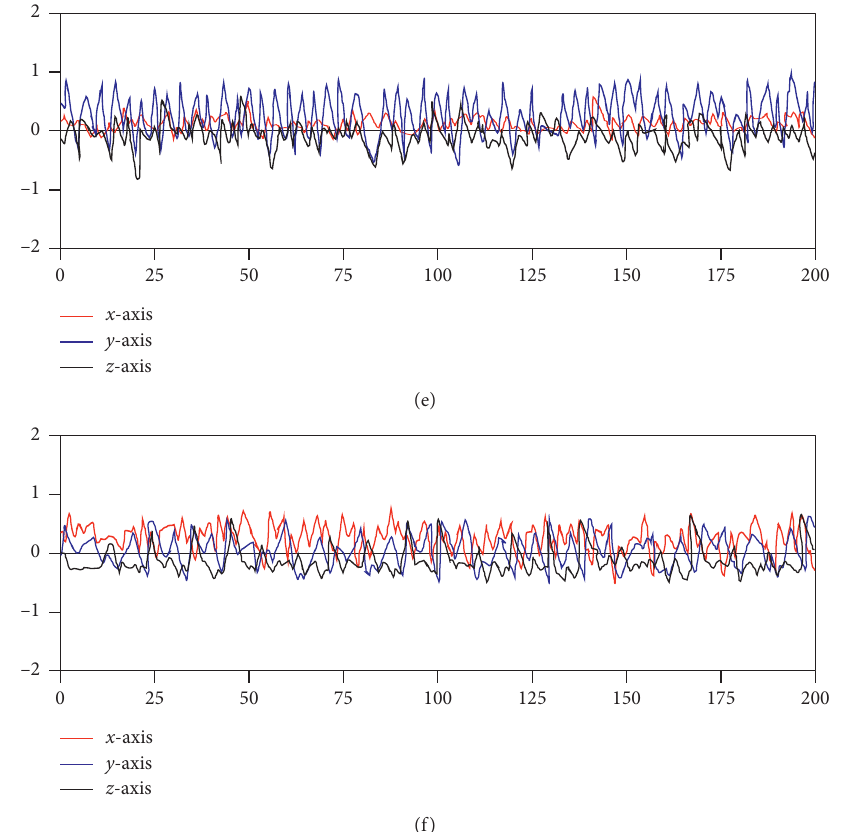
Figure 5: Three-axis acceleration change graph for different scenarios. (a) Three-axis acceleration change graph of downstairs. (b) Three-axis acceleration change graph of upstairs. (c) Three-axis acceleration change graph of standing. (d) Three-axis acceleration change graph of sitting. (e) Three-axis acceleration change graph of running. (f) Three-axis acceleration change graph of